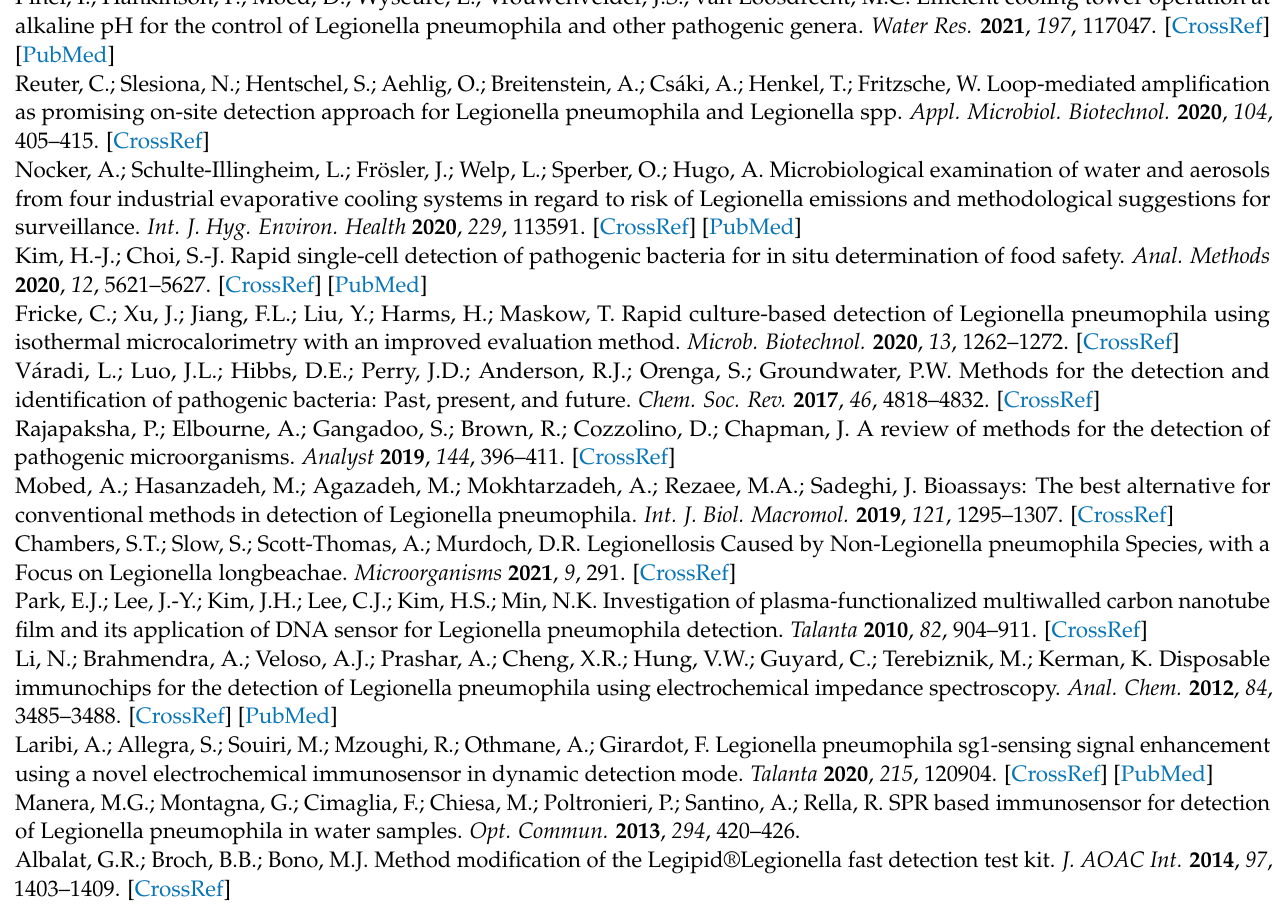
Figure S5: Normalized PL intensity of AMP functionalized GaAs/AlGaAs DIP biochips exposed to L. pneumophila SG1 and SG5 at 50 CFU/mL and decorated with pAb, Table S1: FTIR absorbance bands corresponding to the assigned functional